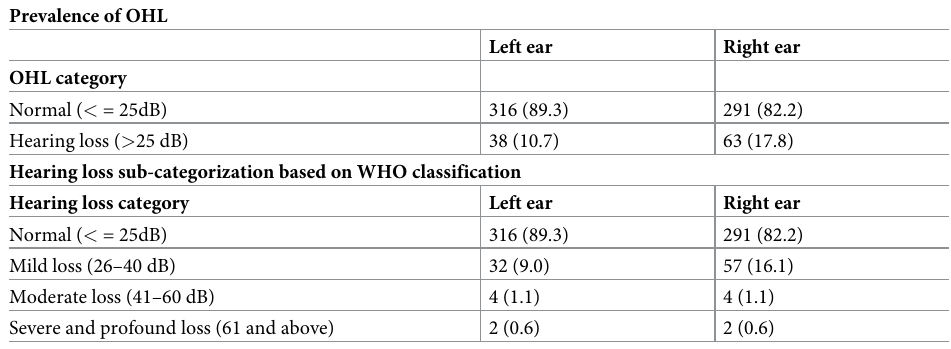
Table 2. Occupational hearing loss among industrial workers.